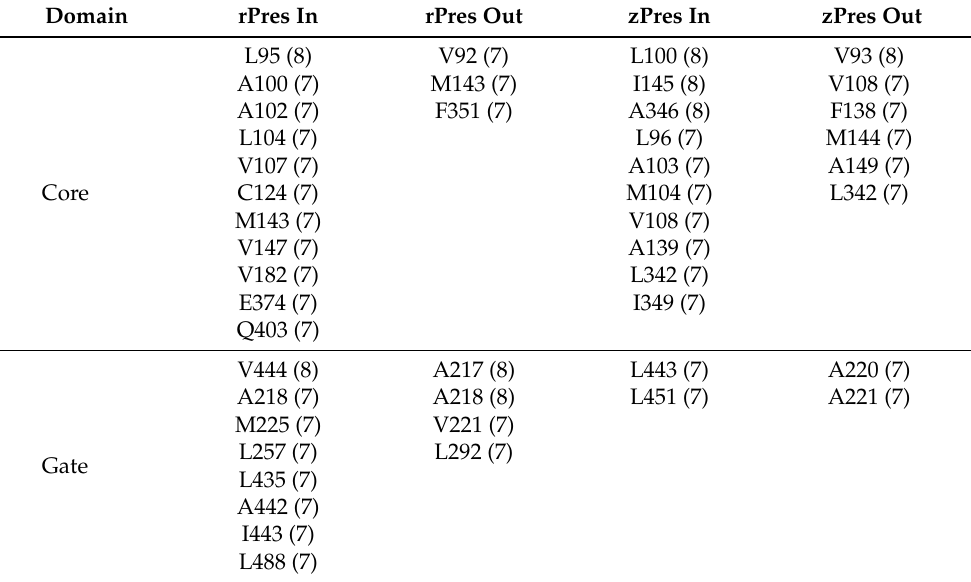
Table 1. Residues with the largest number of interactions, as computed with PyInteraph [49]. The number of connections (indicated in parentheses for each residue) includes H-bonds, salt bridges, and hydrophobic